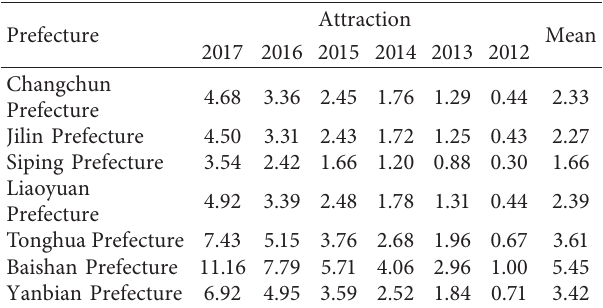
Figure 1: Tourism statistics of Changbai Mountains scenic area. Table 2: Symbiosis correlation between each prefecture and Changbai mountains scenic